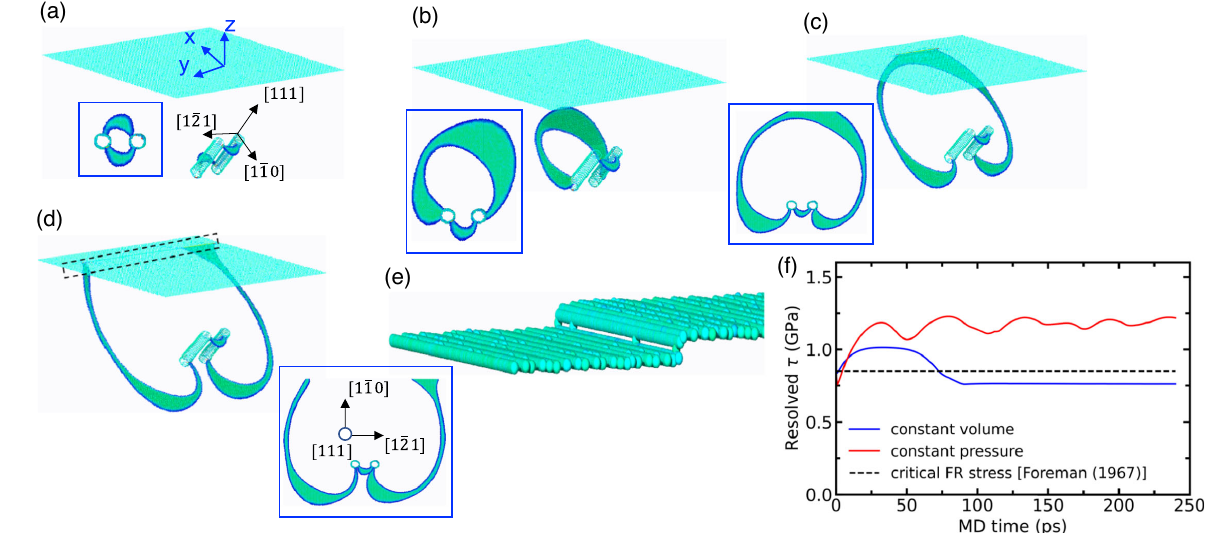
FIG. 1. Activation of Frank-Read sources in fcc Cu where an initially undeformed edge dislocation (a) starts to bow out (b) under sufficient external stress. The emitted dislocation loop then approaches the free surface (c) eventually exiting (d) to leave behind a surface step (e). Resolved shear stress required to maintain the activation (f) should be above the critical threshold (black dashed line) which might not be the case always (e.g., see the stresses for constant volume simulations depicted by the blue